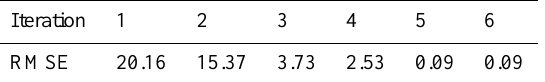
Table 1. The root mean square error given by Eq. (34) for the first six Gauss–Newton iterations, for the Lorenz 63 problem. The whole state is observed. Ensemble size is 100. The assimilation window length is 50 cycles. The finite differences parameter is 10 − 3